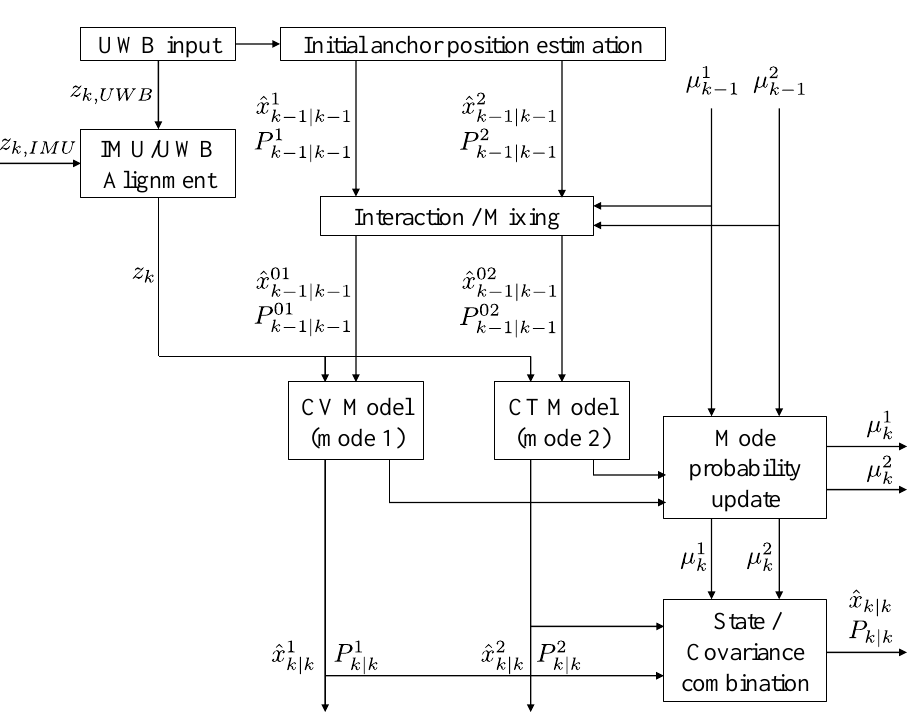
Figure 2. Flow chart of the proposed